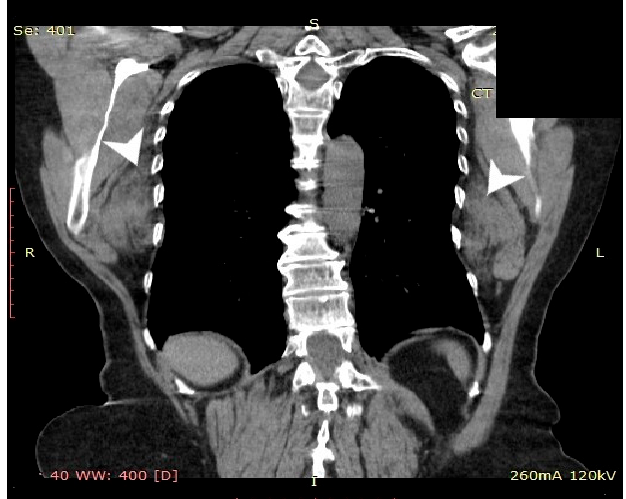
Figure 2. Coronal CT view of the thoracic region. The tumoral lesions are indicated by white arrows.